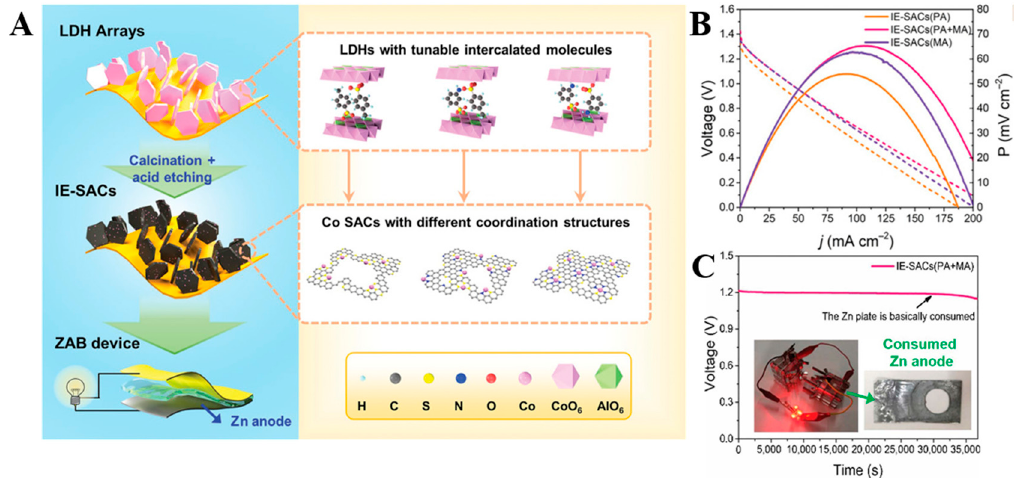
Figure 16. ( A ) Schematic representation of IE-SACs obtained via confinement synthesis strategy. ( B ) Polarization curves and corresponding power density plots of the liquid ZABs, 6 M KOH + 0.2 M zinc acetate as the electrolyte. ( C ) Galvanostatic discharge curves of the IE-SAC(PA+MA)-assembled liquid ZAB at 5 mA cm − 2 [234]. Copyright © 2020 Wiley-VCH GmbH.